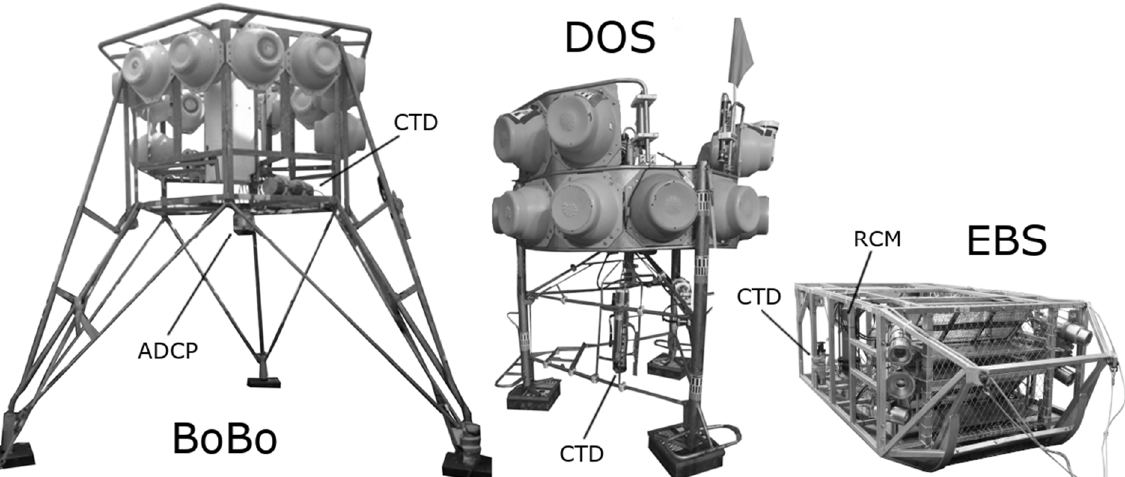
Figure 2. An overview of the boundary layer monitoring devices used in this study. Left to right: Bottom Boundary Layer lander (BoBo) with CTD including a Seapoint turbidimeter at 2.5 mab and the downward ADCP current profiler at 2 mab; Deep-sea Observation System (DOS) with CTD including a Seapoint at 1 mab; Epi-benthic sledge (EBS) with CTD including a Seapoint at 0.5 mab and recording current meter (RCM) at 1 mab. The EBS towed by RV Sonne was used as the seafloor disturber.